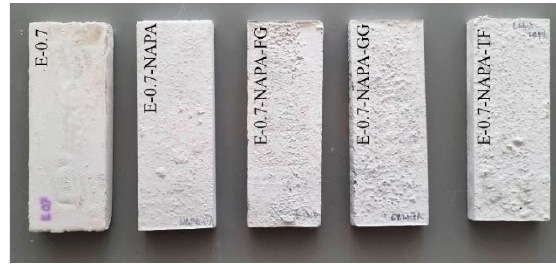
Figure 13. Fire ignitability test machine.